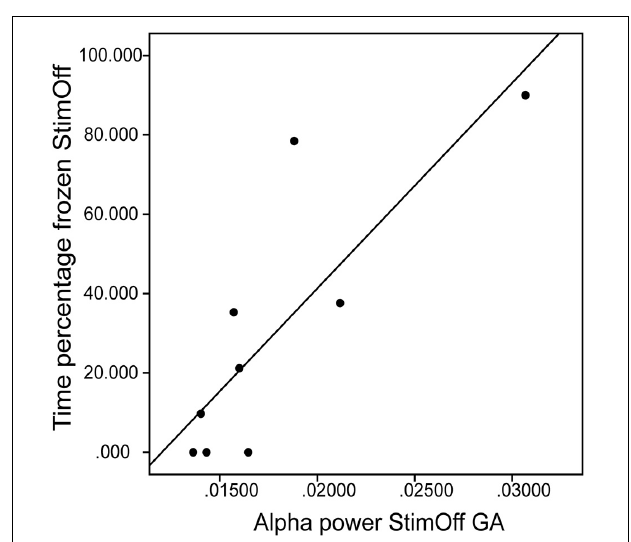
FIGURE 5 | Correlation between the alpha/low beta peak maxima of the GA ( x -axis) and the time percentage frozen in ‘StimOff’ ( r = 0.763, p = 0.017). Higher alpha/low beta peak maxima are associated with longer freezing